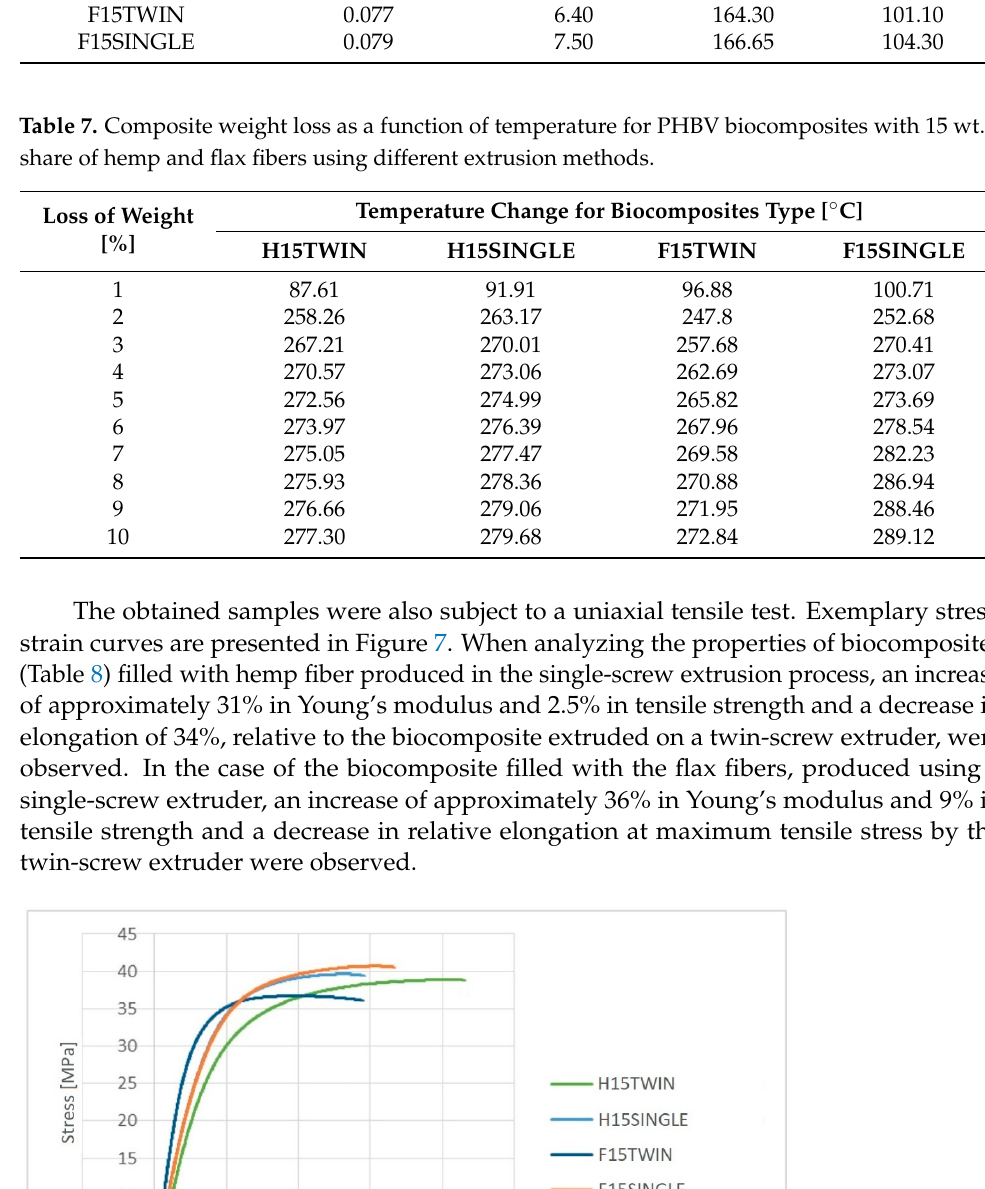
Table 6. Selected thermal properties of PHBV biocomposites containing 15% (by weight) of hemp or flax fibers produced in the extrusion technology.